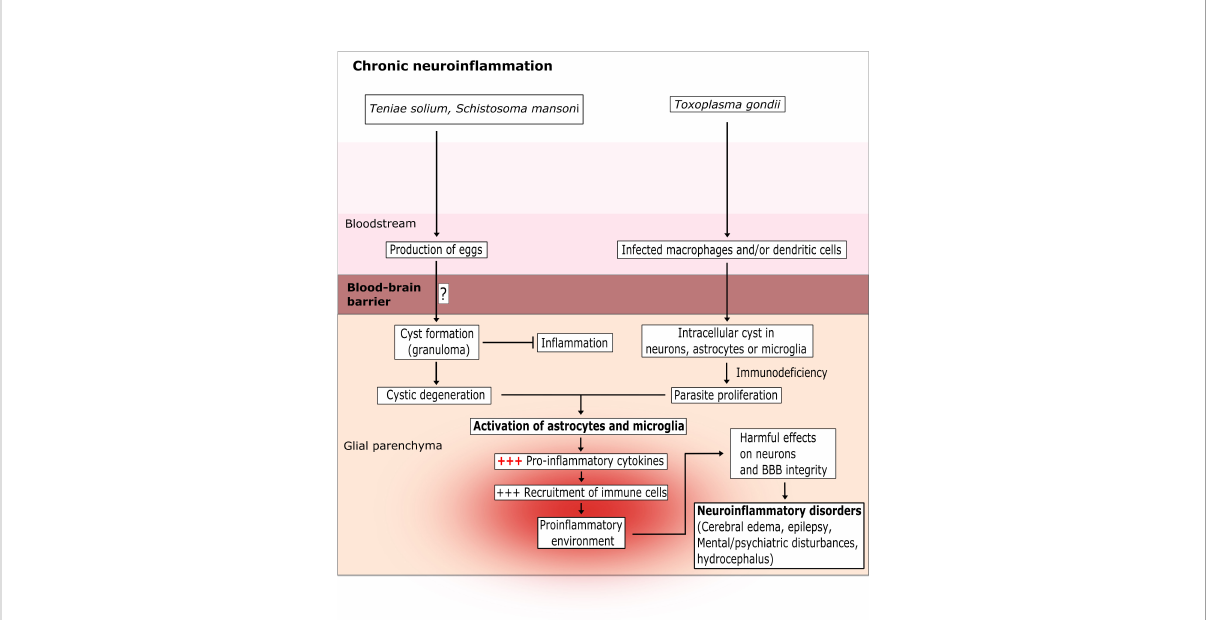
FIGURE 3 The chronic latent brain in fl ammation induced by parasite infection. T. solium and S. mansoni are intestinal parasites. Their eggs pass into the blood and then cross the BBB via as-yet unknown mechanisms. T. gondii infects leukocytes and crosses the BBB via a “ trojan horse ” mechanism or via a paracellular or transcellular route. Once inside the glial parenchyma, the parasites form extracellular cysts (for T . solium and S . mansoni ) or intracellular cysts (for T . gondii ) in neurons and microglia cells. The cysts can survive for several years and induce a low-level pro- in fl ammatory response. However, after few years or in an immunocompromised state, the cysts degenerate (for T . solium and S . mansoni ) or proliferate (for T . gondii ) and strongly activate astrocytes and microglia cells. In turn, this excessive activation creates a pro-in fl ammatory environment that damages neurons and the